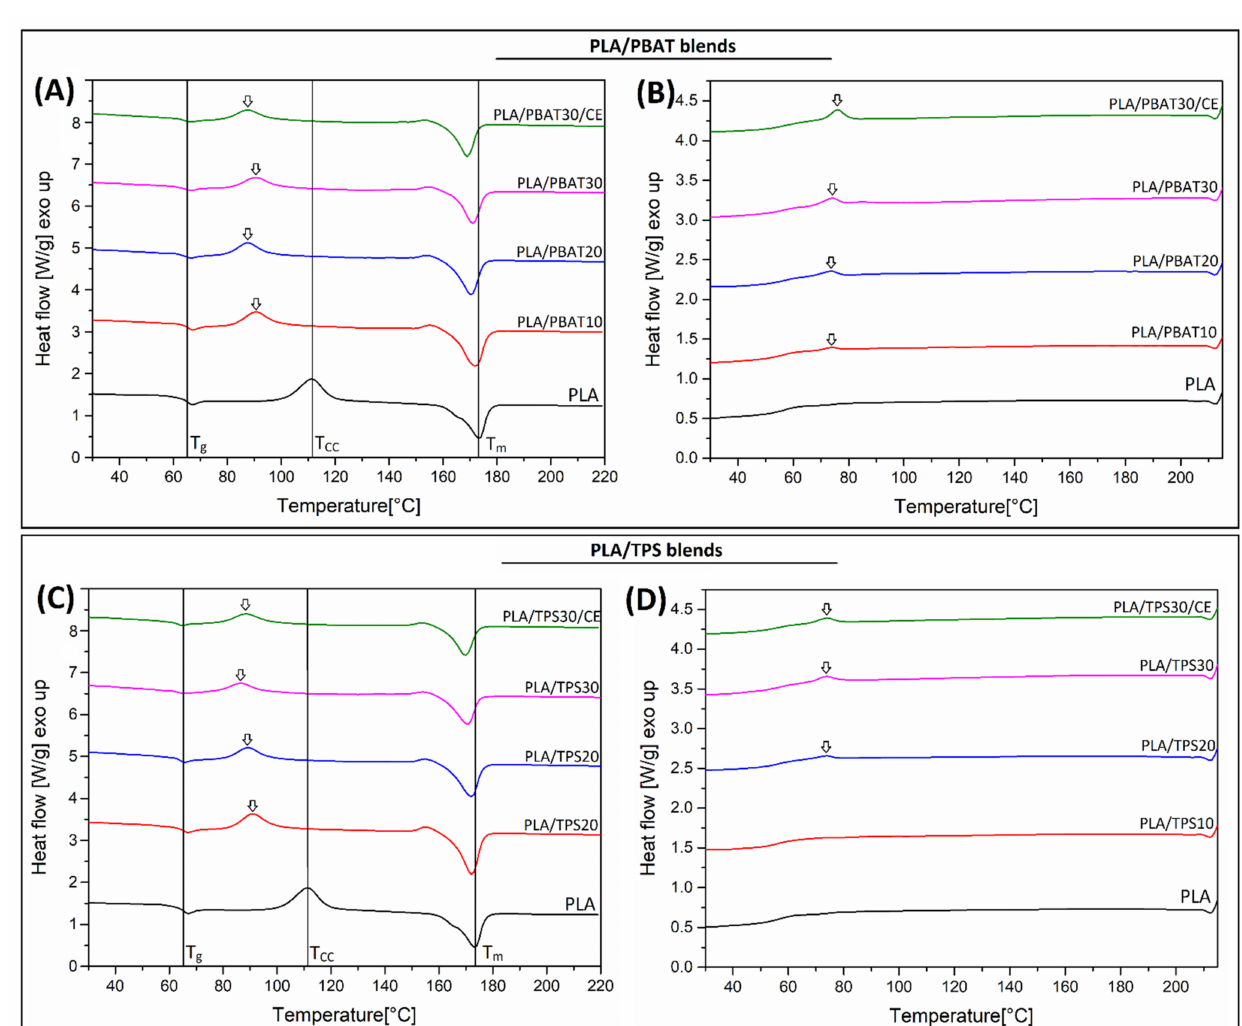
Figure 7. The DSC signal of injection-molded samples. ( A , B ) First heating and cooling thermogram for PLA/PBAT-based materials. ( C , D ) First heating and cooling thermograms for PLA/TPS